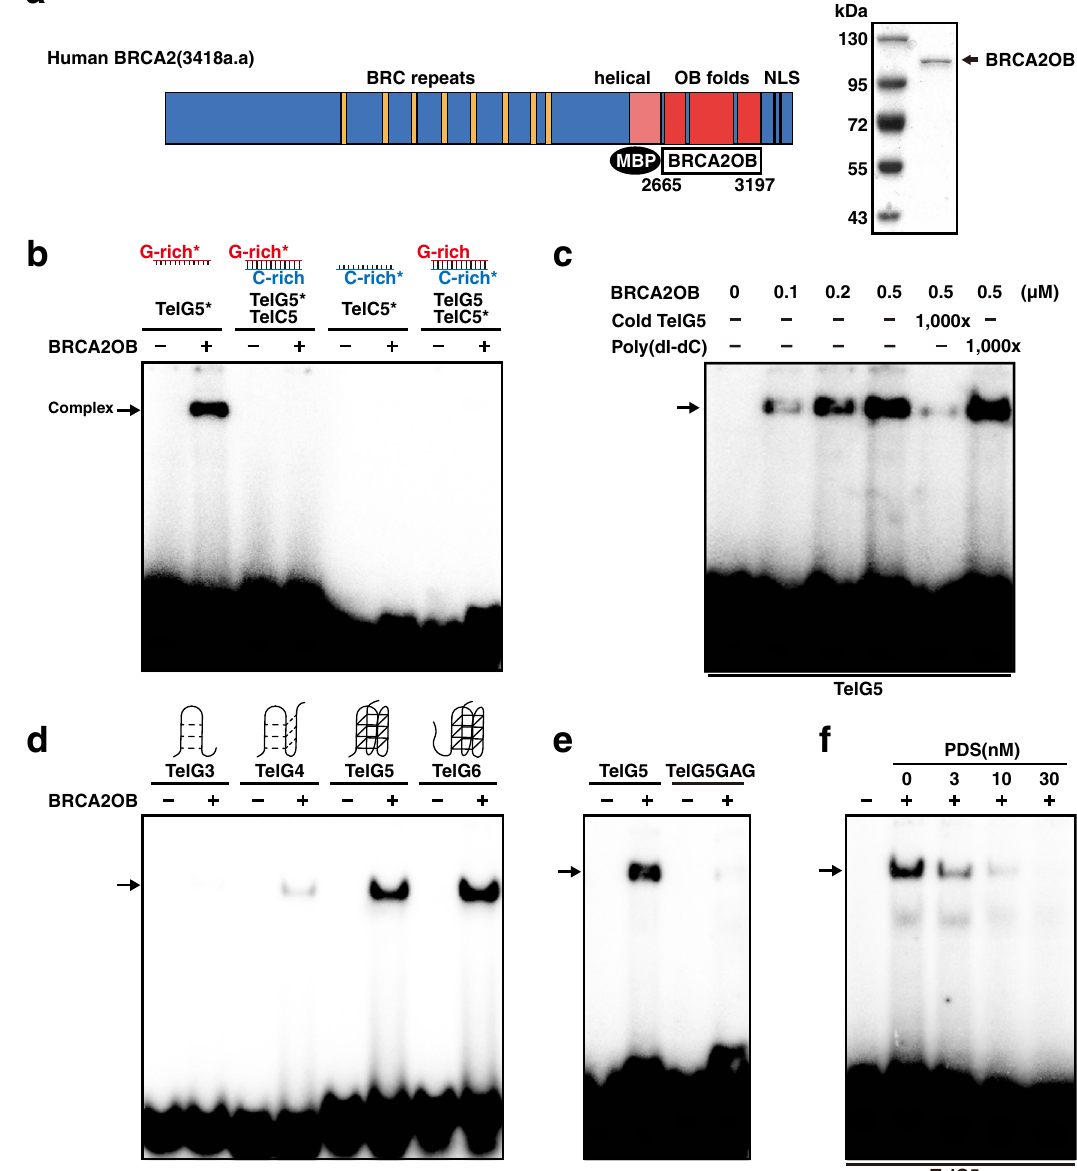
Fig. 1 The BRCA2 OB-folds binds to telomeric G-quadruplexes. a Schematic illustration of human BRCA2. BRC repeats, OB folds, and the nuclear localization signal (NLS) are marked. Recombinant BRCA2 OB-folds domain (2665-3197 a.a.; BRCA2OB), tagged with N-terminal MBP was puri fi ed (SDS- PAGE gel at right). b Electrophoresis mobility shift assay (EMSA) was used to assess binding of recombinant BRCA2OB to telomere repeats. TelG5, G-rich single-stranded (GGTTAG) 5 repeats; TelC5, C-rich strand complementary to TelG5; TelG5:TelC5, double-stranded. 32 P-labeled hot probe is marked with an asterisk(*). Arrow marks the BRCA2OB-bound hot probe. c Increasing concentrations of BRCA2OB were incubated with TelG5 (lanes 2 to 4). Binding speci fi city was con fi rmed by competing with 1000X excess of unlabeled TelG5 ( + , Cold TelG5, lane 5) and Poly(dI-dC) for negative control (lane 6). d Single-stranded (ss) telomeric repeat oligonucleotides of increasing length (TelG3 – TelG6, see illustration at the top) were incubated with ( + ) or without (-) BRCA2OB and subjected to EMSA. The binding of BRCA2OB to telomere repeats was detected from TelG5 and TelG6. e BRCA2OB speci fi cally binds to TelG5, which forms the G-quadruplex (G4), but not to the single-stranded mutant (TelG5GAG). f A G4 ligand PDS challenges the binding of BRCA2OB to G4 in a dose-dependent manner. EMSA analyses were performed in the presence of 100 mM KCl. All experiments were repeated more than three times